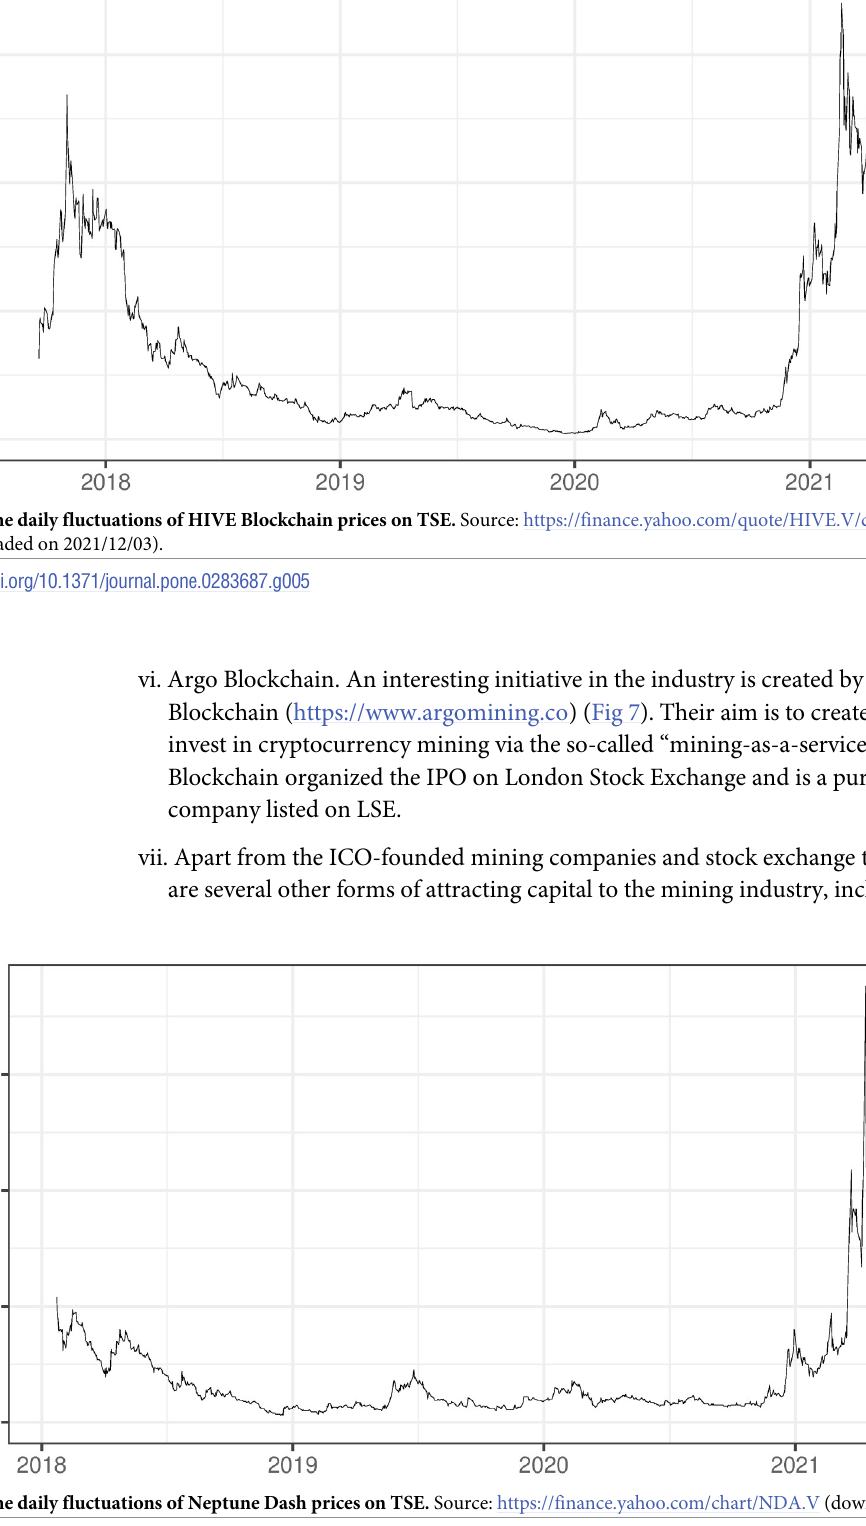
PLOS ONE | https://doi.org/10.1371/journal.pone.0283687 March 30,